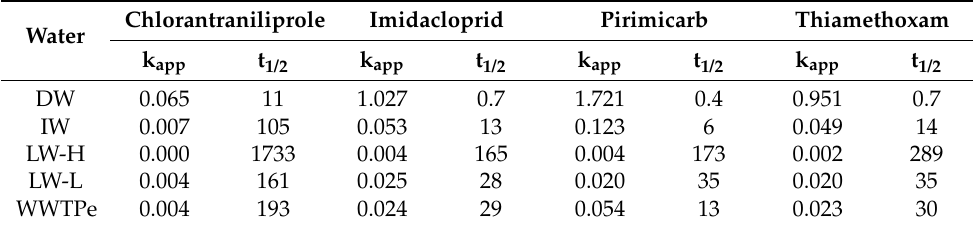
Table 1. Degradation rate constant (k app , min − 1 ) and half-lives (t 1/2 , min) of each insecticide in each tested water (n =